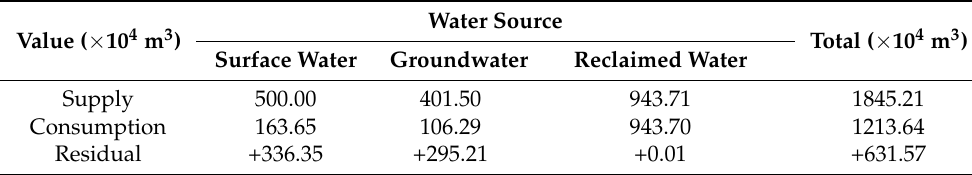
Table 12. Supply-demand balance analysis after optimal allocation of water resources in the study